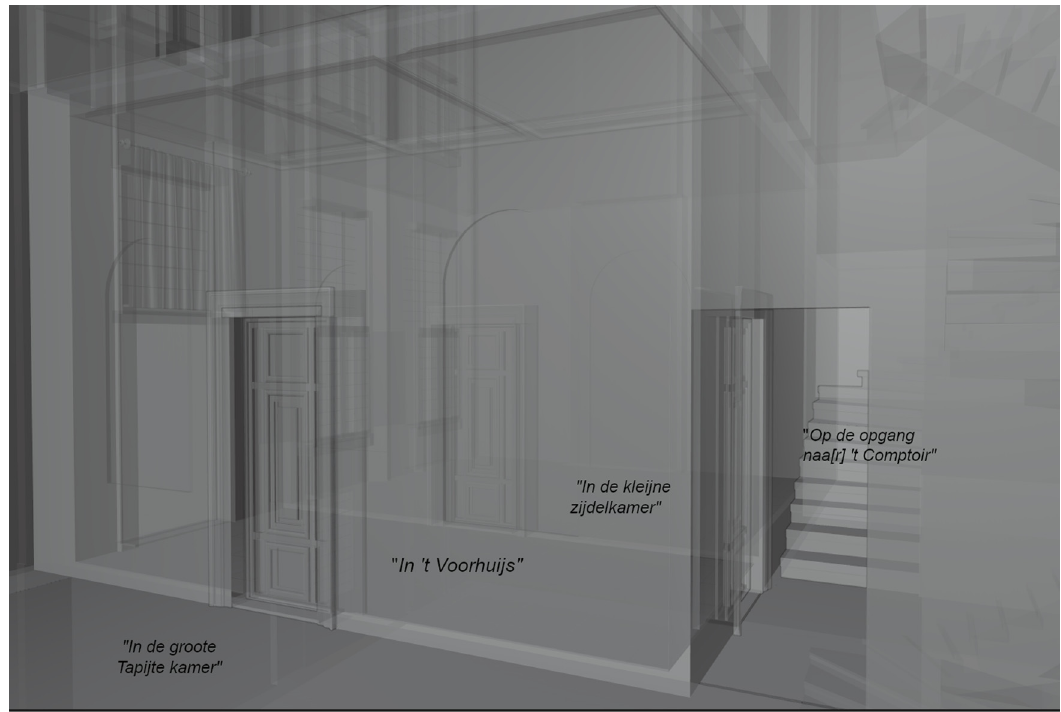
Figure 4: The portion of the reconstructed house showing the spatial context of the voorhuis with the locations that are mentioned before and after it in De Grae ff ’ s probate inventory.